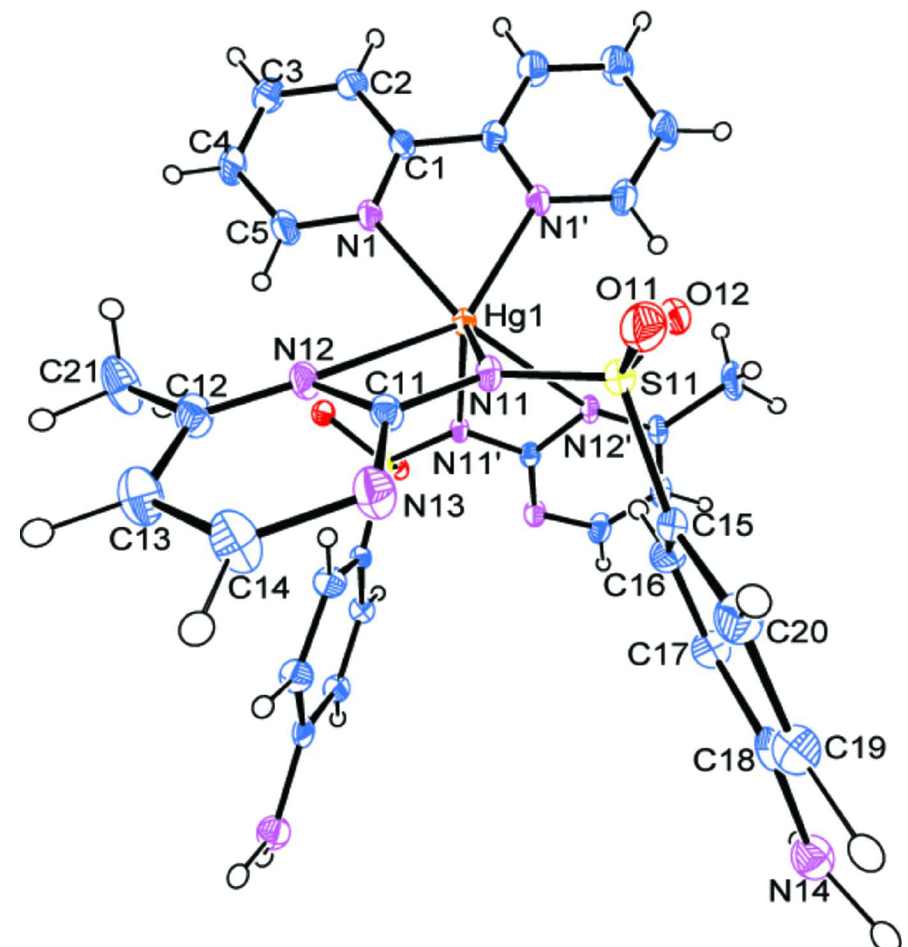
Figure 1 The molecular structure of (I), with 50% probability displacement ellipsoids for non-H